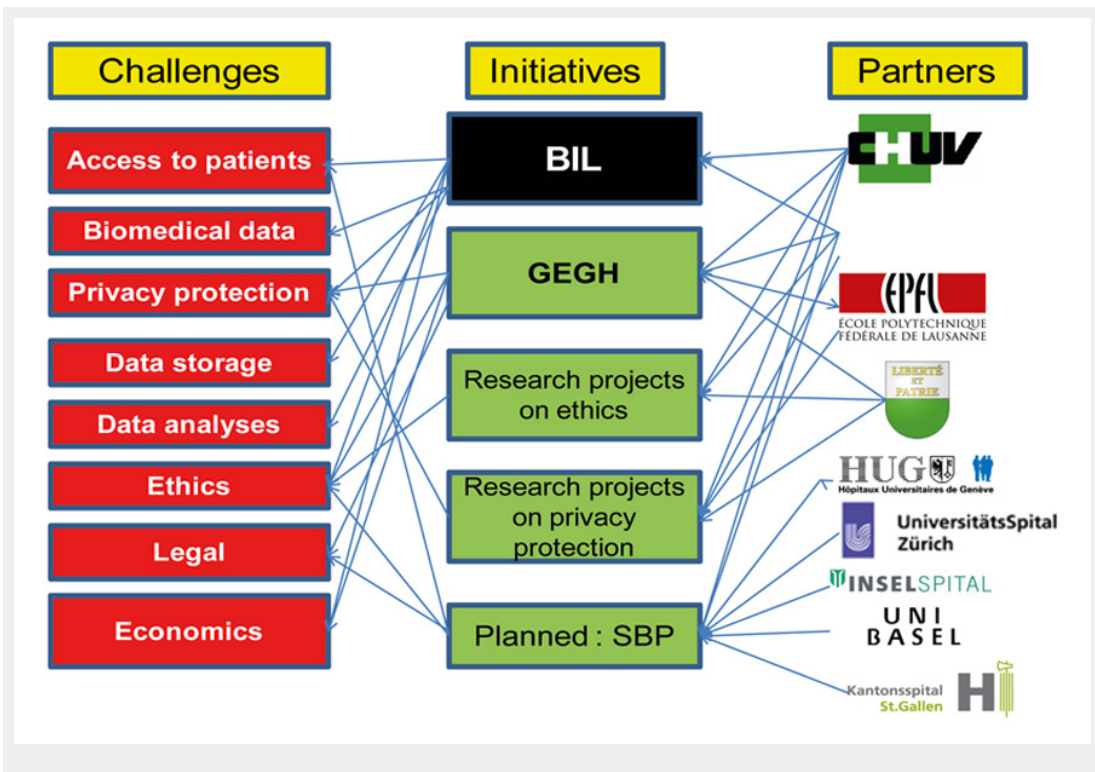
Figure 3 Landscape of the Lausanne Institutional Biobank (BIL). Selected challenges associated with the construction of a bio-resource like the BIL are listed on the left-hand side. Partners in addressing these challenges are listed on the right-hand side and the BIL and parallel projects are listed in the middle. GEGH = Groupe d’Experts sur le Génome Humain (http://www.vd.ch/actualite/articles/experts-en-medecine-genomique/). SBP = Swiss Biobanking Platform, at the planning stage. An overview of the local activities on the societal aspects of genomic medicine, ethics, privacy protection and personalised medicine is provided in references [17–19] and